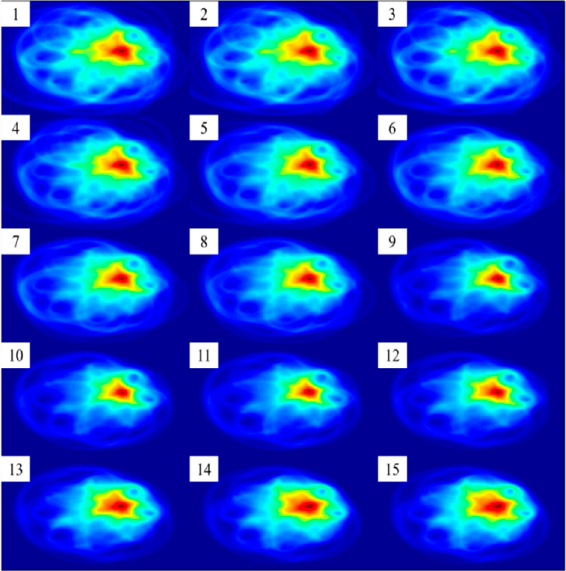
Figure 13. Case 1 imaging results of probabilistic ellipse imaging algorithm at different SDC thresh ‐ olds.